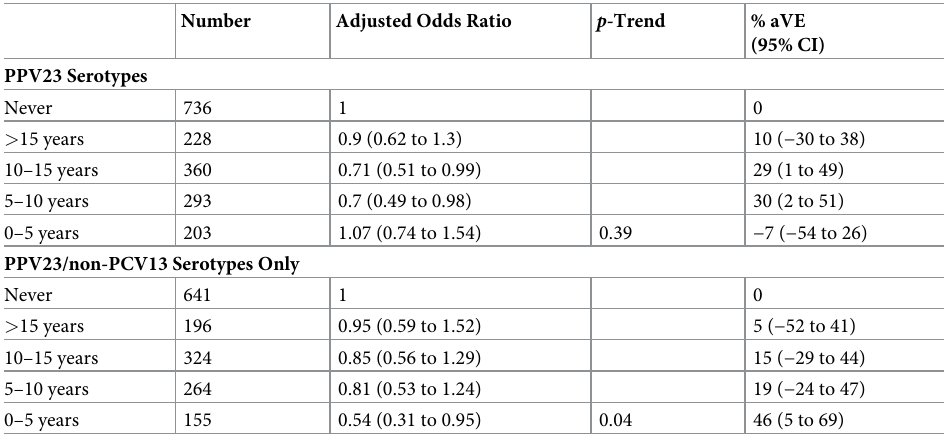
Table 3. Time from vaccination